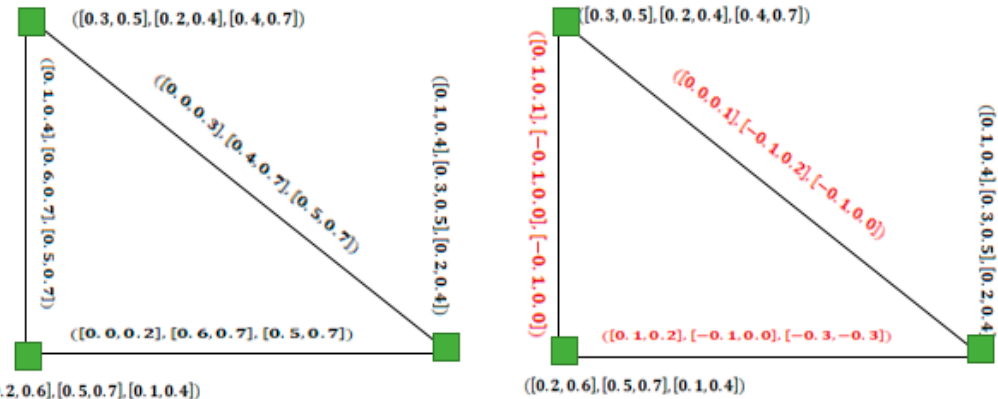
Figure 22. Complement of the Interval-valued neutrosophic graph by Definition 15.